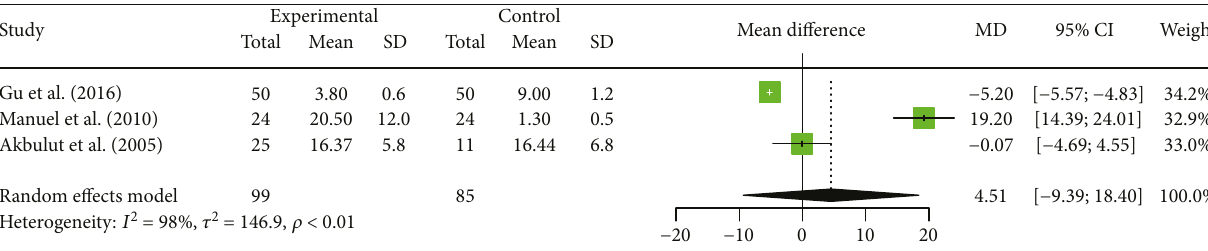
Figure 6: Forest plot of the changes of peripheral blood Th1 cell in human brucellosis patients compared with controls.